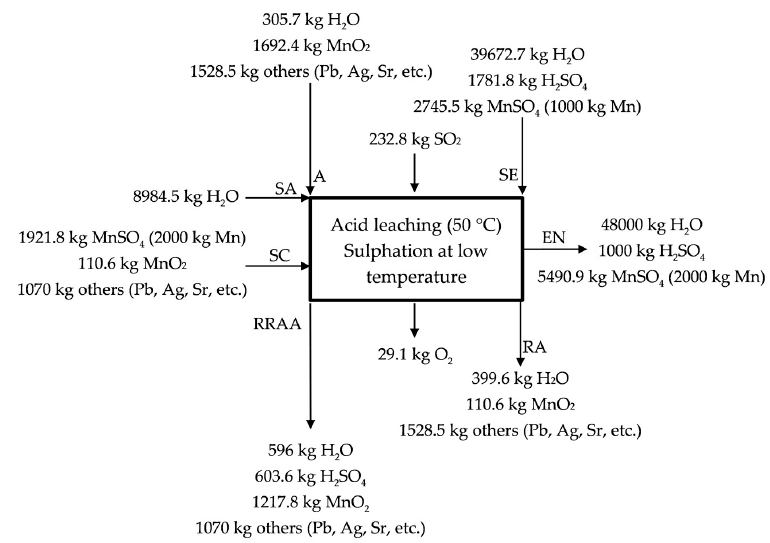
Figure 3. Description of the acid leaching at low temperature (50 °C).